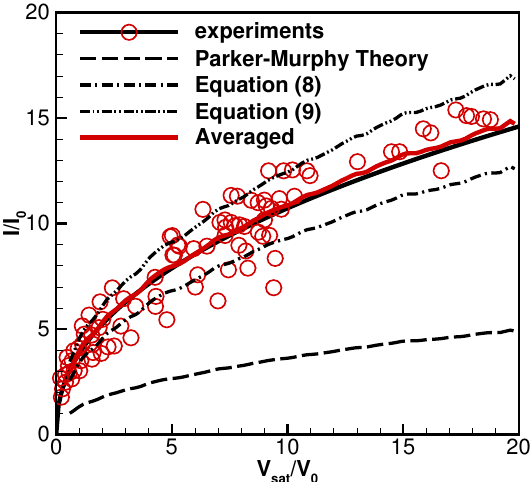
Figure 5. Comparisons of current-voltage results. Symbols: measurements in space mission (solid black line: the best fitting curve); Long dashed line: P-M theory; Black dash-dot lines: new enhancement factors (solid red line: their